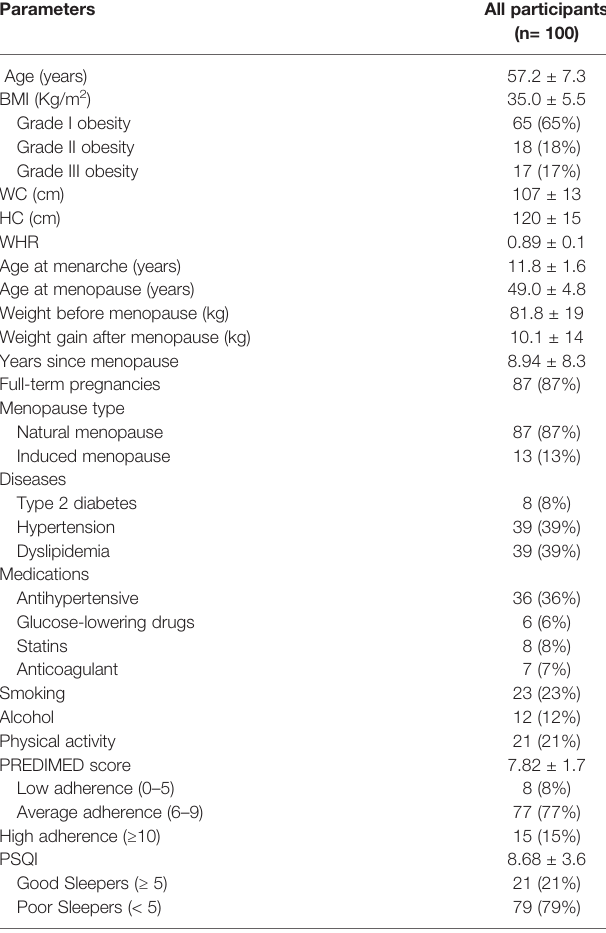
TABLE 2 | Frequency distribution of Menopause Rating Scale (MRS) scores and menopausal symptoms. MRS and